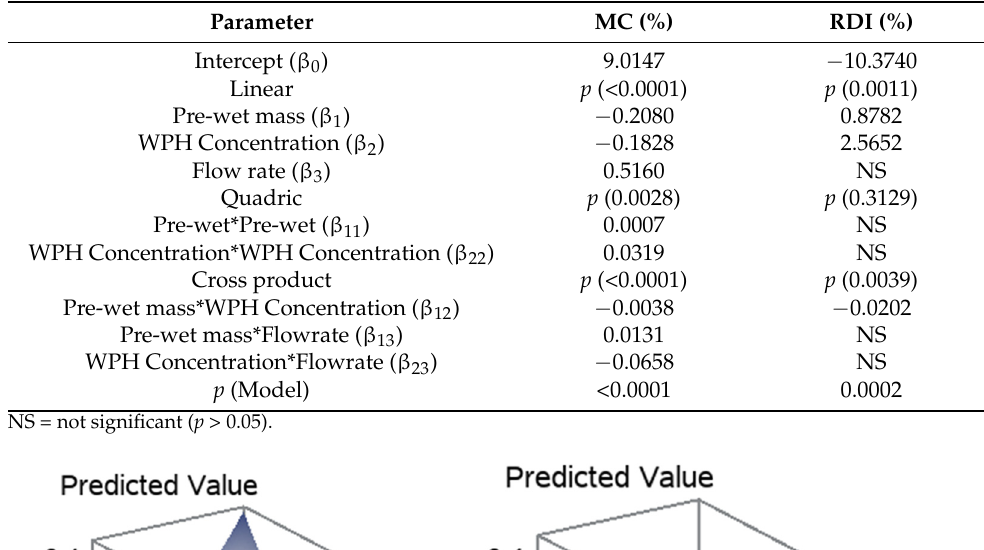
Table 5. The coefficients of moisture content and relative dissolution rate models for the response variables.